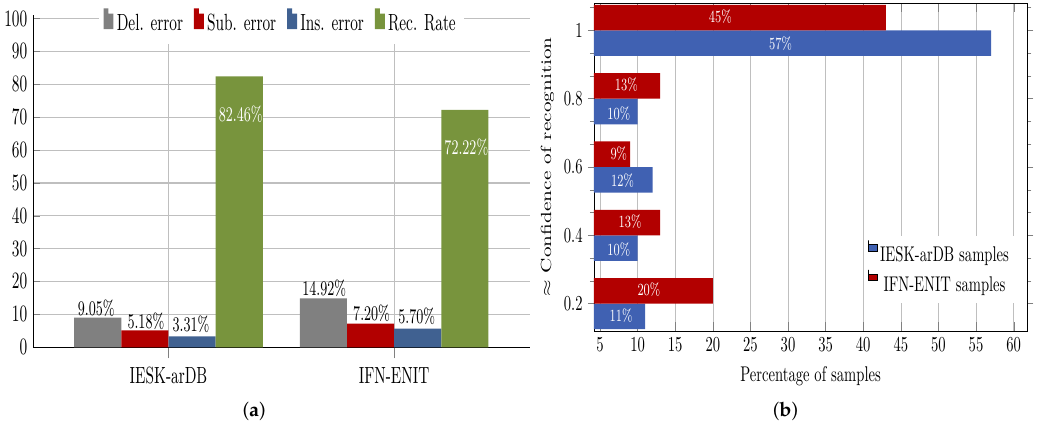
Figure 6. Recognition rates obtained on letters and words: ( a ) recognition achieved on letter samples from two different databases along with observed classification errors; ( b ) percentage of recognized words with the respective recognition reliability